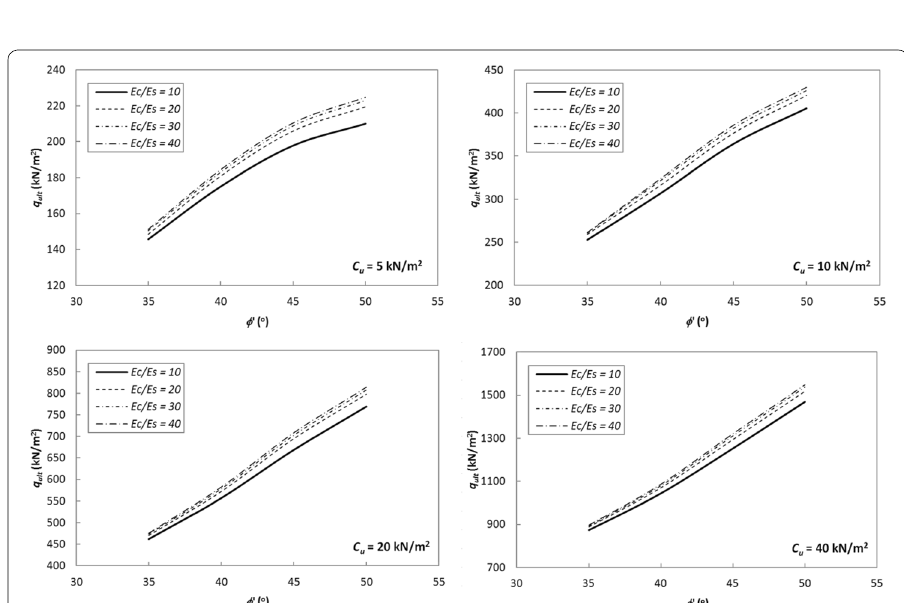
Fig. 8 Ultimate bearing capacity versus friction angle of column